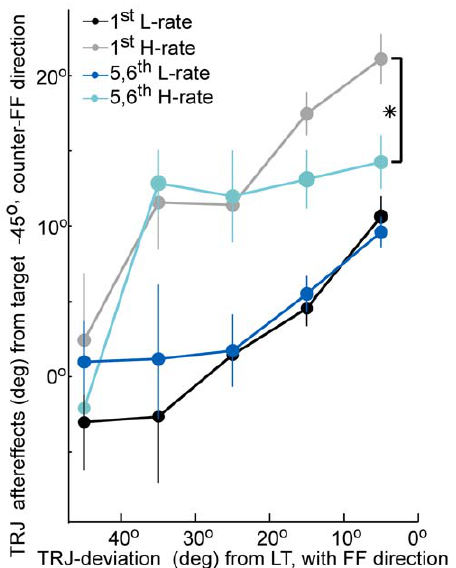
Figure 9. The generalization effect under H-rate is larger than under L-rate but more labile. The figure depicts the trajectory aftereffects (no force-field) to the target at 2 45 u as a function of the trajectory deviations to the learned target under the force-field (in bins of 10 u ) for trials that immediately followed a force-field trial (1 st -trials, L- rate in black, H-rate in grey) and aftereffects after 5–6 trials (5,6 th -trials, L-rate in blue, H-rate in cyan). Note that for any directional deviation from the learned target smaller than 40 u , the immediate aftereffects under H-rate (grey) were significantly larger than under L-rate (black). However, note also that under H-rate the large aftereffects significantly decay within 5 trials (asterisk), while under L-rate they do not show such decay. Error bars denote SEM. Asterisks denote 1%